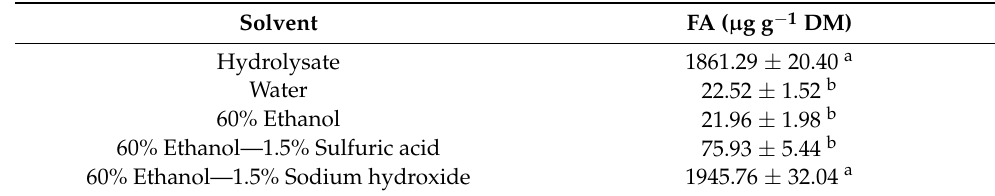
Table 4. Ferulic acid content of wheat bran determined after performing various treatments. Values represent means of triplicate treatments ± standard